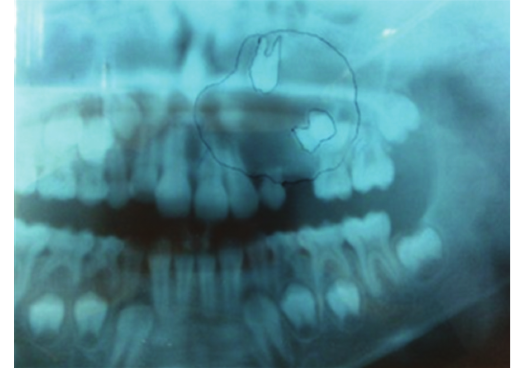
Figure 3: OPG View.